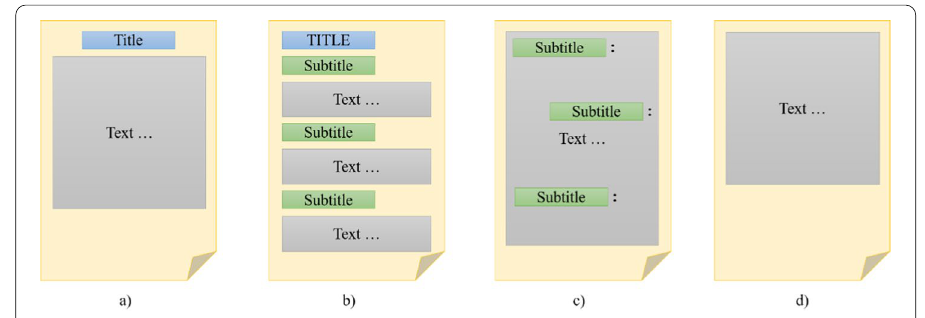
Fig. 2 Different forms of unstructured textual EHR